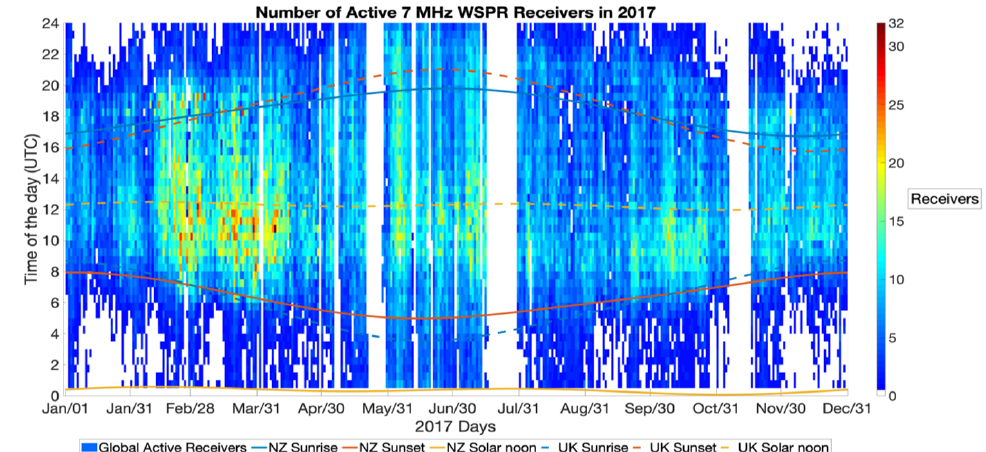
Figure 5. Number of global active receivers operating at 7 MHz in 2017. Only receivers with a proven capability to cover the distance from the station ZL3TKI to any radio stations were considered. The colours indicate the number of active transmitters received in each half-hour interval.